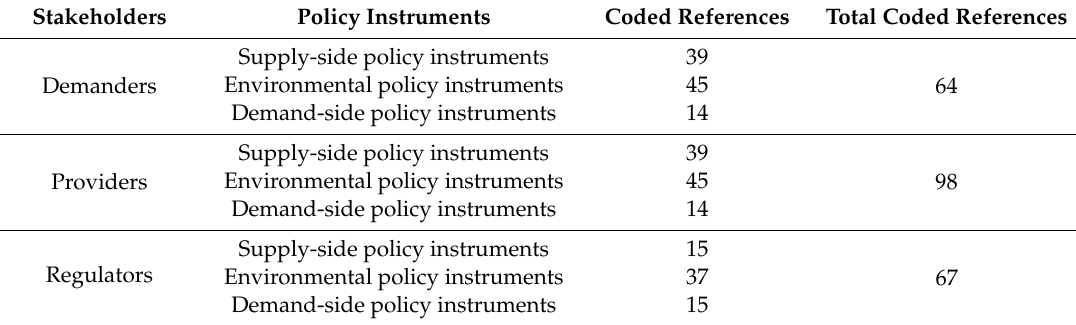
Table 3. Coded references of policy instruments based on stakeholders.